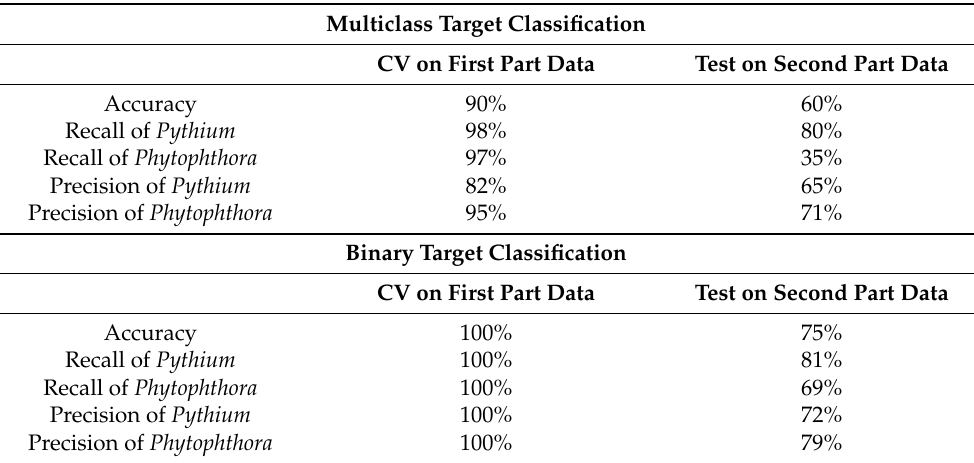
Table 4. Results of models trained on data from only one sensor (TGS 6302). Two methods to calculate various machine learning models’ performance measures were used: cross-validation performed on the data collected in the first part of the experiment and tested on a separate dataset of observations collected in the second part of the